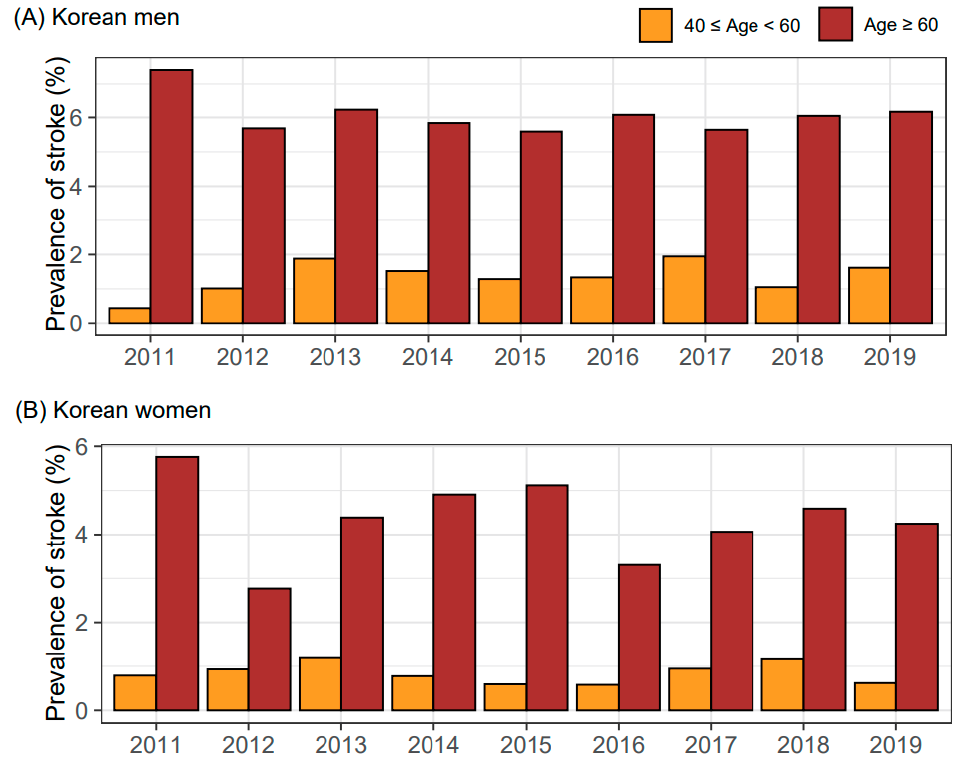
Figure 1. Sex-specific prevalence of stroke according to the 2011–2019 KNHANES datasets. Prevalence Figure 1. Sex ‐ specific prevalence of stroke according to the 2011–2019 KNHANES datasets. was calculated using weighted Korean men ( A ) and women ( B ). Abbreviation: KNHANES, Korea Prevalence was calculated using weighted Korean men ( A ) and women ( B ). Abbreviation: National Health and Nutrition Examination KNHANES, Korea National Health and Nutrition Examination Survey.